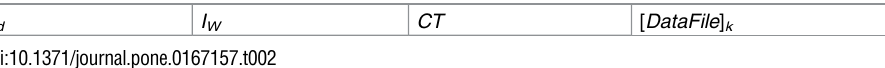
Table 2. File Storage Format in